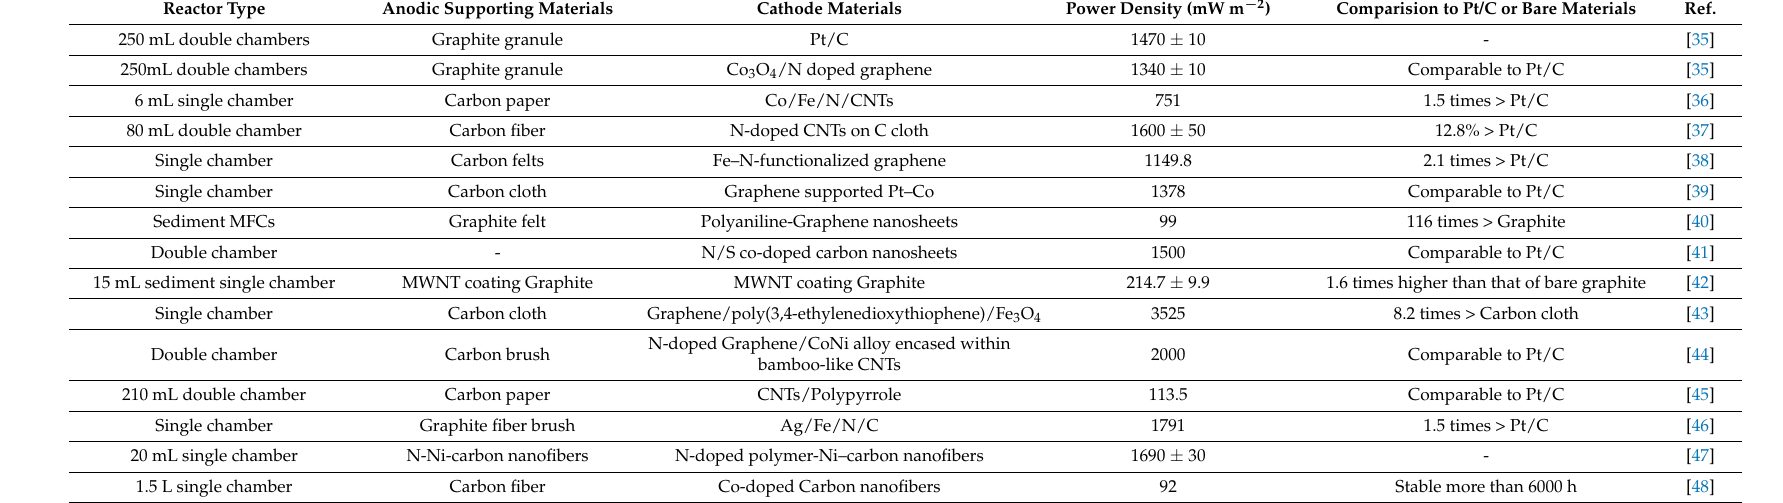
Table 1. Summary of carbon-based nanomaterials (CBNs) recent achievements in microbial fuel cells (MFCs) towards enhanced cathode